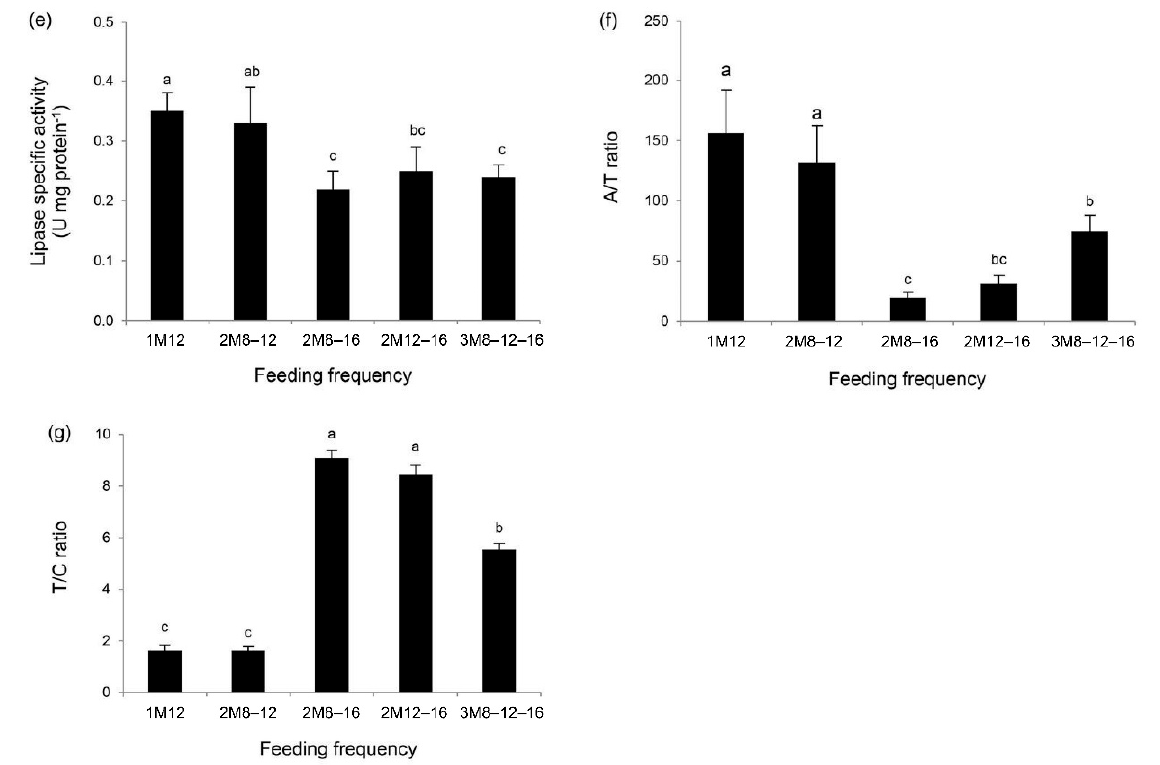
Figure 1. Specific activities of fecal digestive enzymes in hawksbill sea turtle fed at different frequencies: pepsin ( a ), trypsin ( b ), chymotrypsin ( c ), amylase ( d ), lipase ( e ), A/T ratio ( f ), and T/C ratio ( g ). The feces were sampled at the end of the eight-week experiment. Data are expressed as tank mean ± SEM. Different superscripts indicate a significant difference ( p < 0.05). A/T ratio is the ratio of amylase to trypsin; T/C ratio is the ratio of trypsin to chymotrypsin.